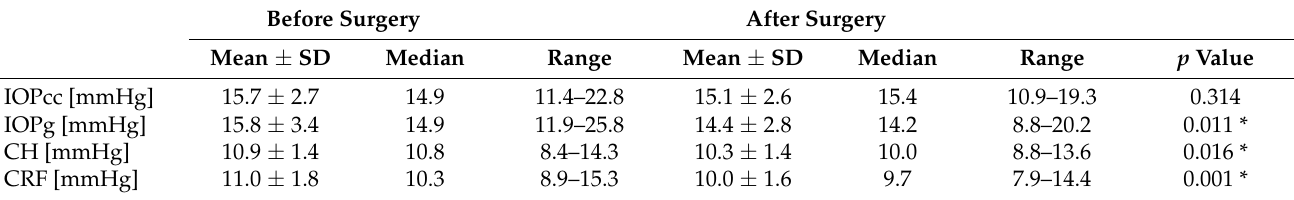
Table 3. Ocular response analyzer measurements.